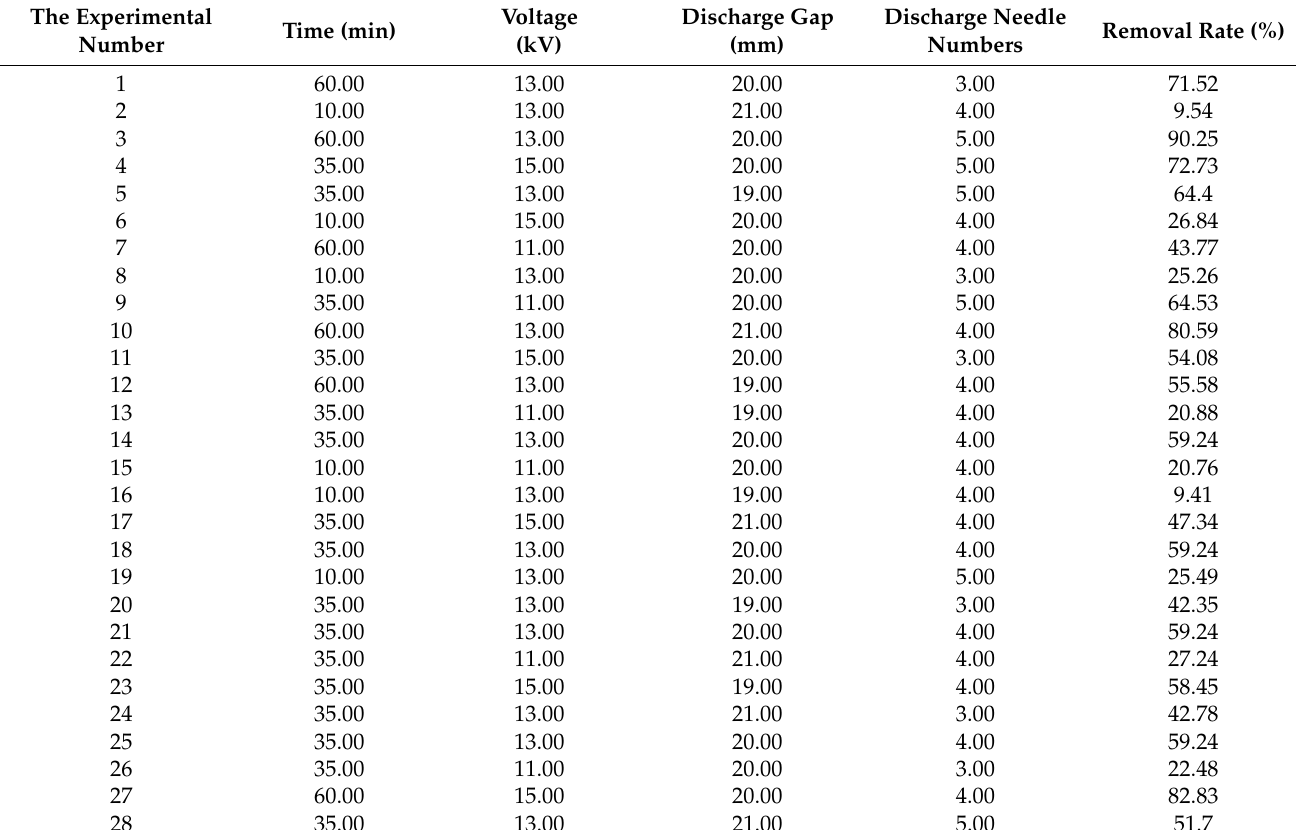
Table 2. Results of the removal experiment of MO.